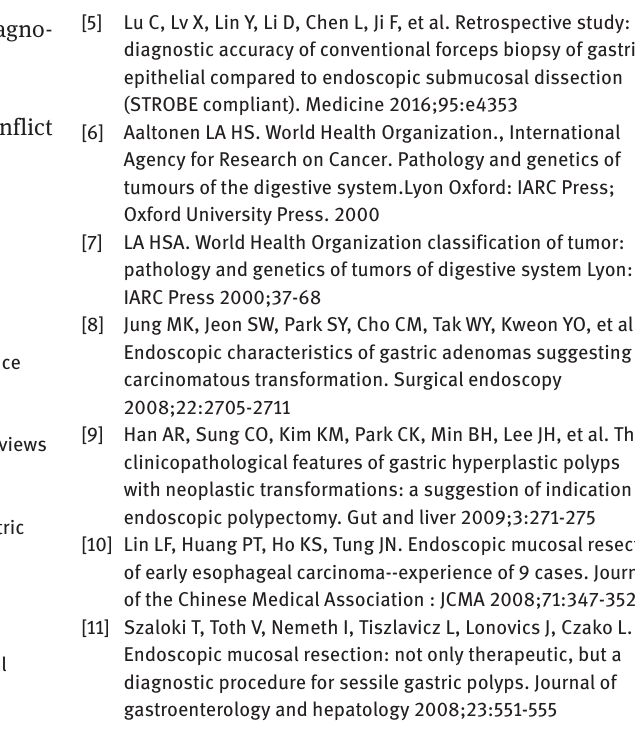
Figure 1: A) gastric mucosa with swell and surface hyperemia under conventional endoscopy; B) CFB histological result showed LGIN (HE×400); C) NBI found that the demarcation between the lesions and surrounding mucosa mouth shape was irregular and the missing of mucosa capillary network; D) ESD image; E) the shape of ESD specimen was 2.0cm×2.5cm; F) postoperative histological result showed moderately differentiated adenocarcinoma, which was limited to the mucosa and close to the mucosal muscularis, and the lateral cutting edge and base cutting edge were all negative